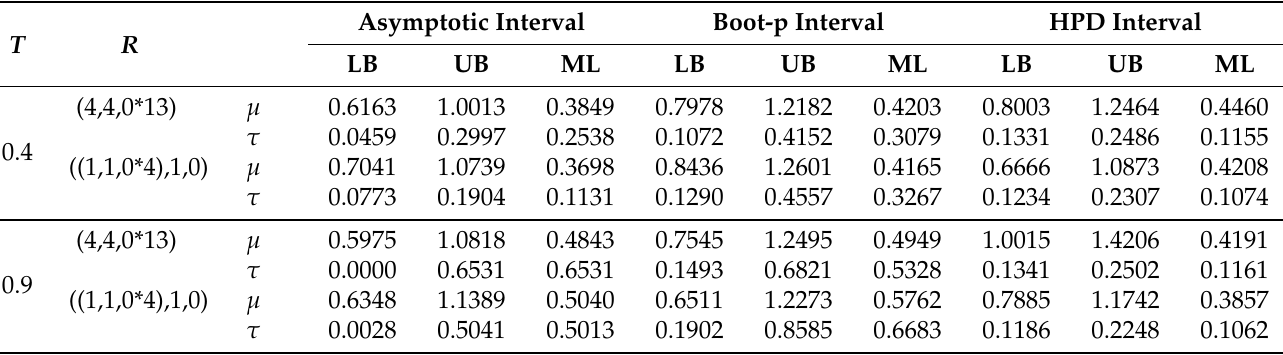
Table 7. Interval estimation results of µ and τ on the real data